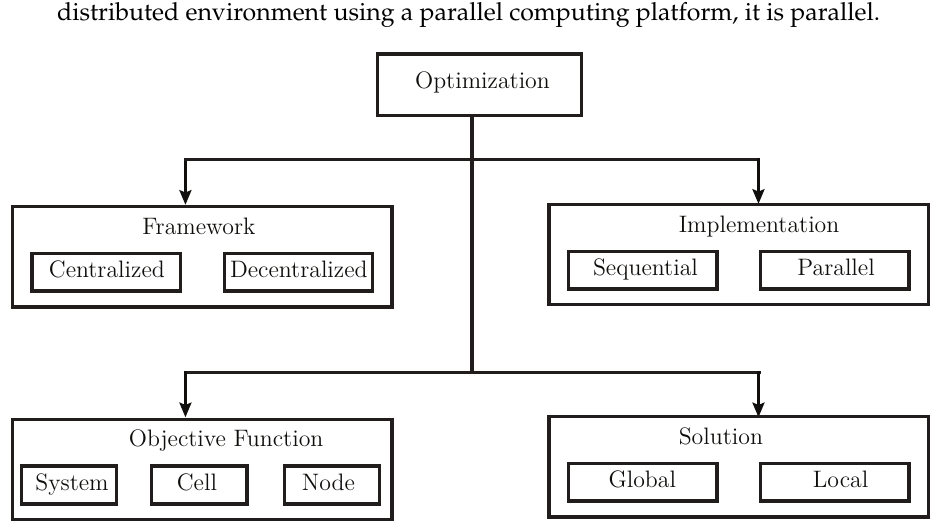
Figure 1. The classification of optimization based on framework, implementation, objective function, and